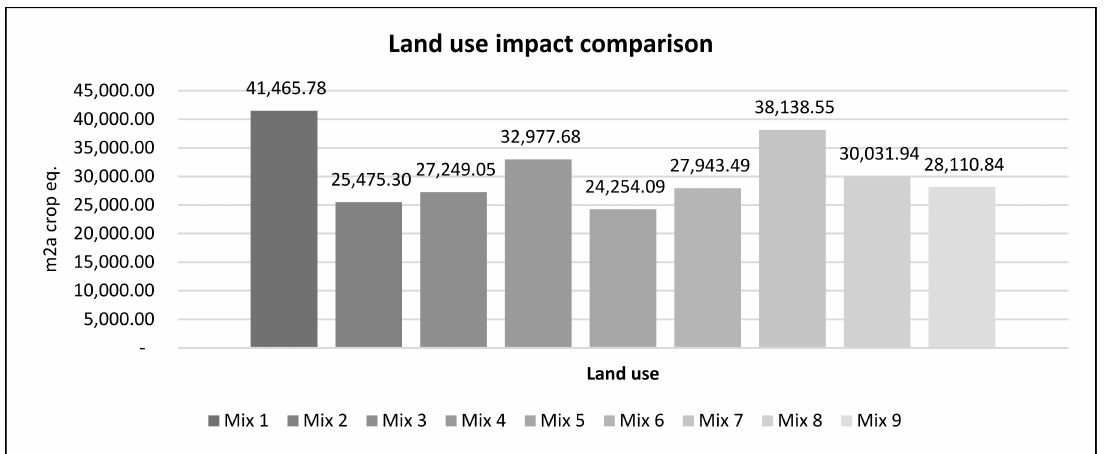
Figure 8. Land use impact comparison between mineral sealing mix